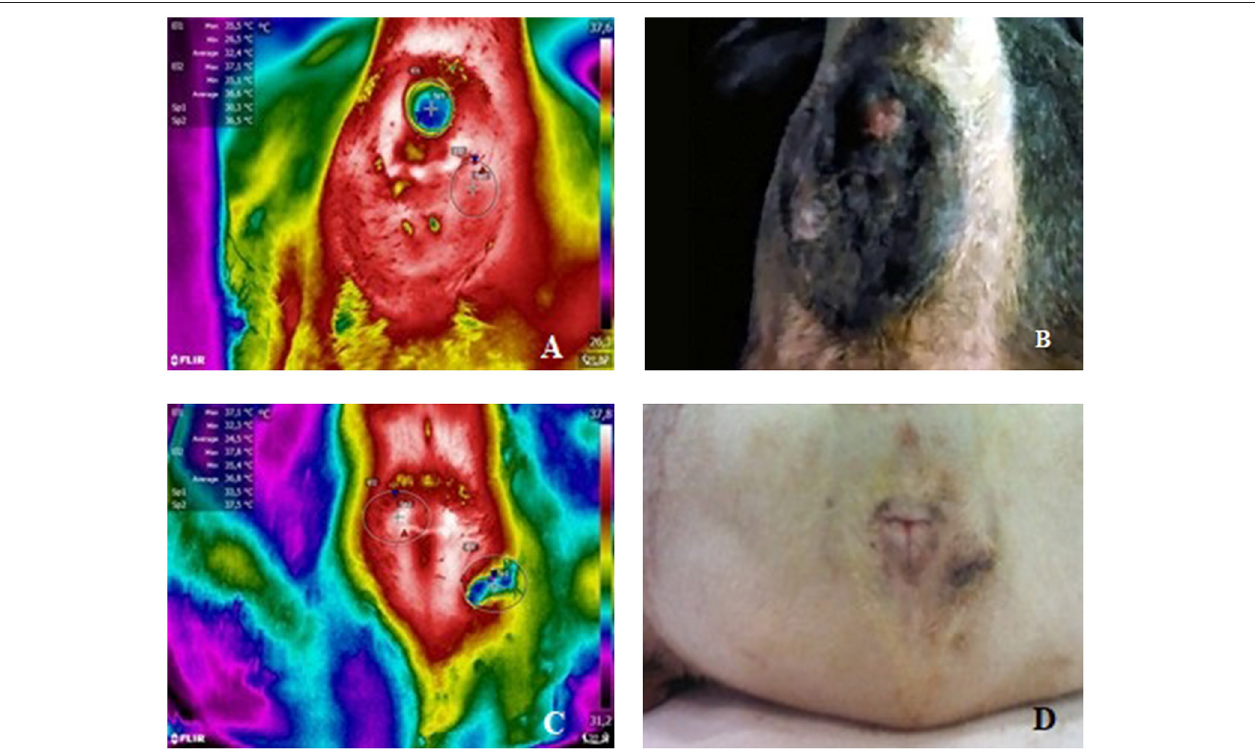
FIGURE 1 | (A) Thermal image of patient 50 (CAGA) depicting SpT (Sp1), SpNT (Sp2), TA (E1), and NTA (E2) temperature readings. (B) Corresponding (non-thermal) image. (C) Thermal image of patient 28 (CAGAC) depicting SpT (Sp1), SpNT (Sp2), TA (E1), and NTA (E2) temperature readings. (D) Corresponding (non-thermal)